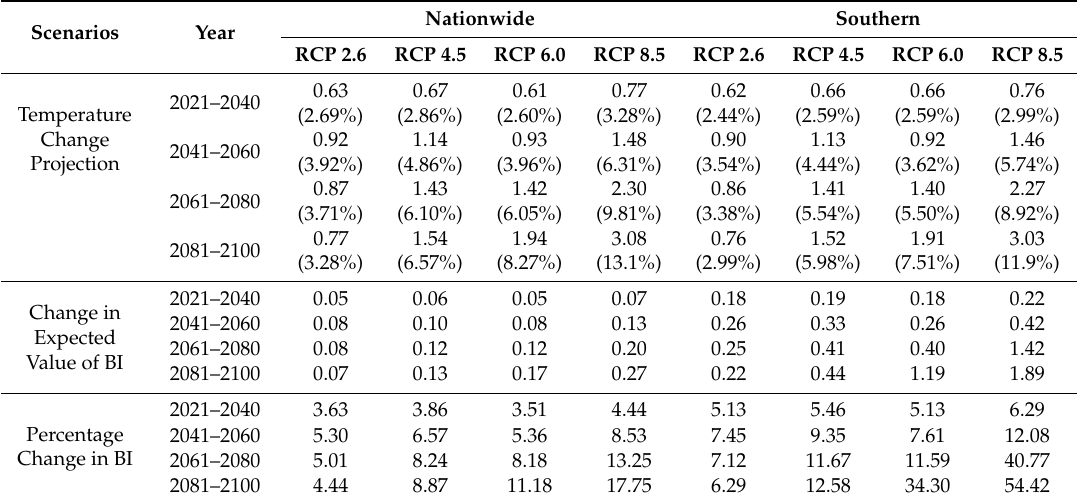
Table 8. Percentage change in Breteau index under climate change